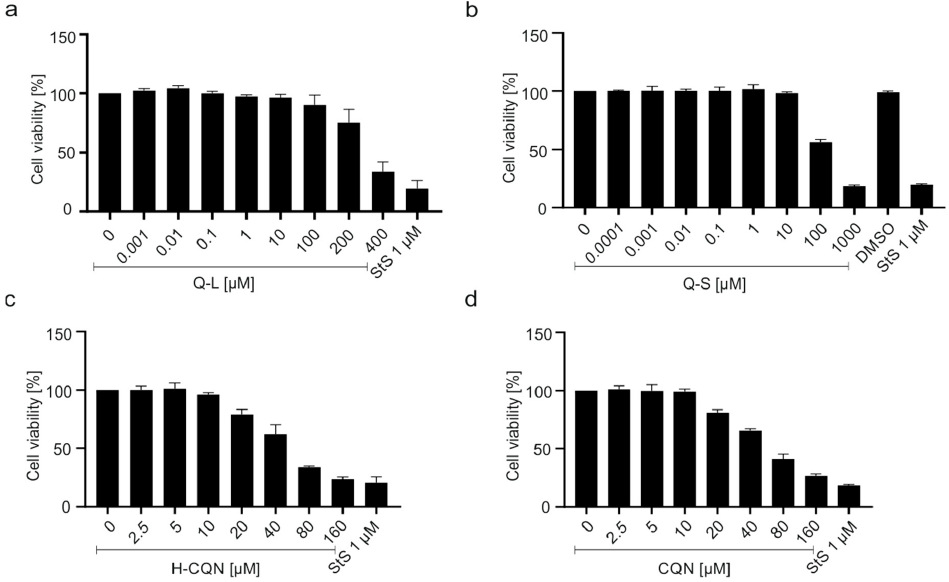
Figure 2. Influence of quinine ( a , b ), H-CQN ( c ), and CQN ( d ) on the cell viability of Vero B4 cells. Cells were treated for 72 h with ( a ) Q-L, ( b ) Q-S, ( c ) H-CQN, and ( d ) CQN to the protocols of the infection experiments. The influence on cell viability was measured by water-soluble tetrazolium salt (WST)-1 assays. Quinine-sulfate was used as ( a ) Q-L or ( b ) Q-S. Bars represent mean values of 3 independent experiments (cid:3399) SD.